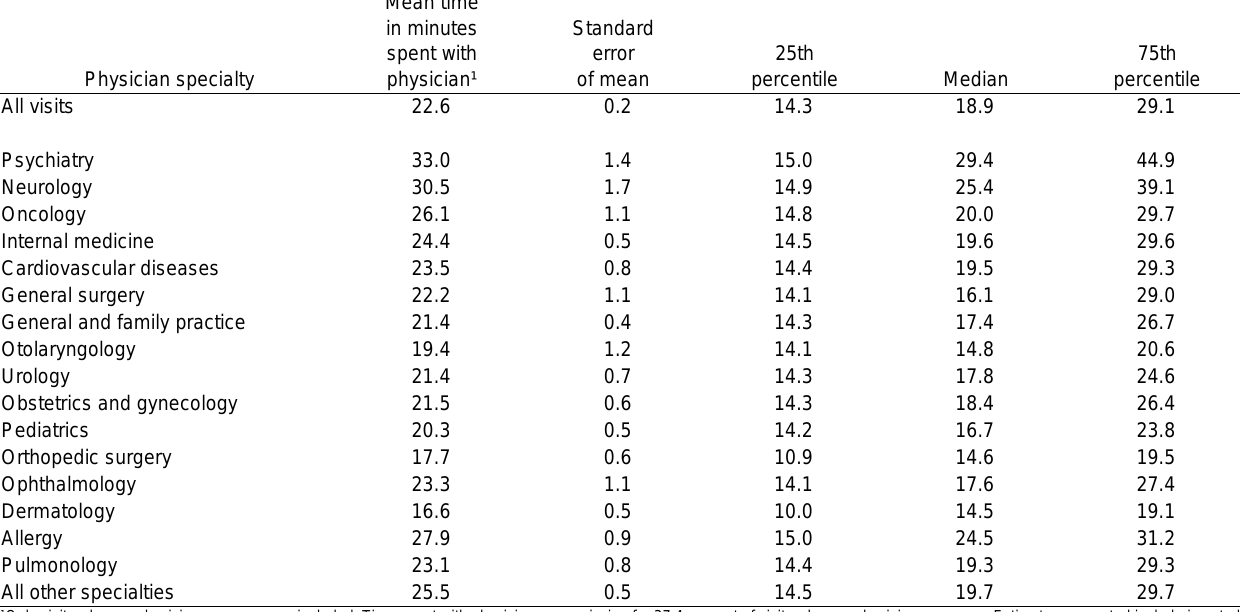
¹Only visits where a physician was seen are included. Time spent with physicians was missing for 37.4 percent of visits where a physician was seen. Estimates presented include imputed values for missing data. SOURCE: CDC/NCHS, National Ambulatory Medical Care